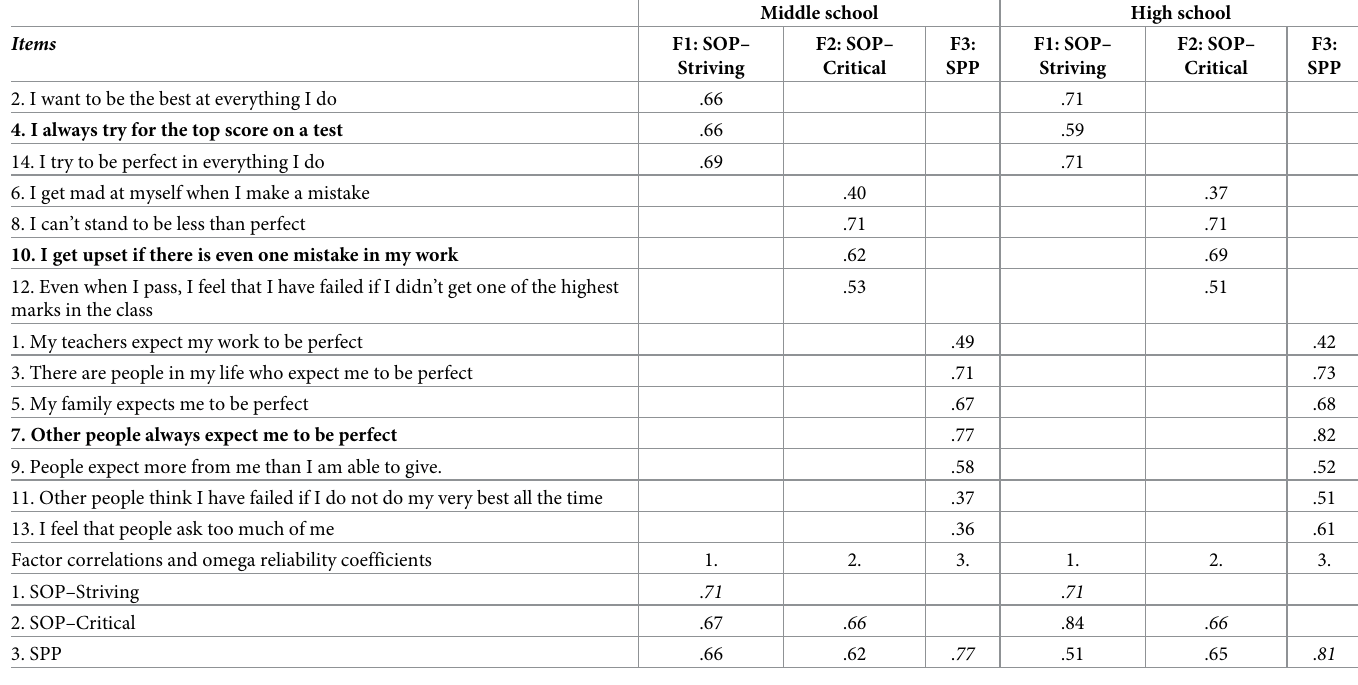
Table 2. A CFA on the CAPS-14: Standardized factor loadings, correlations between latent factors, and composite